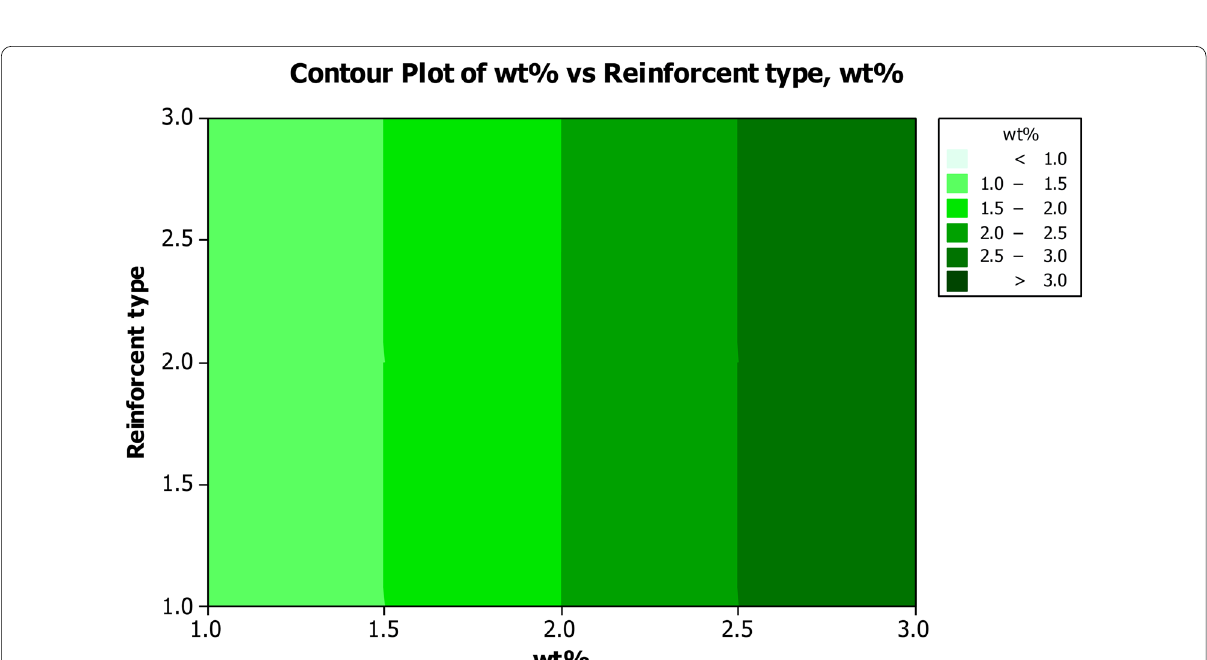
Fig. 15 Contour plot of THR, reinforcement type and